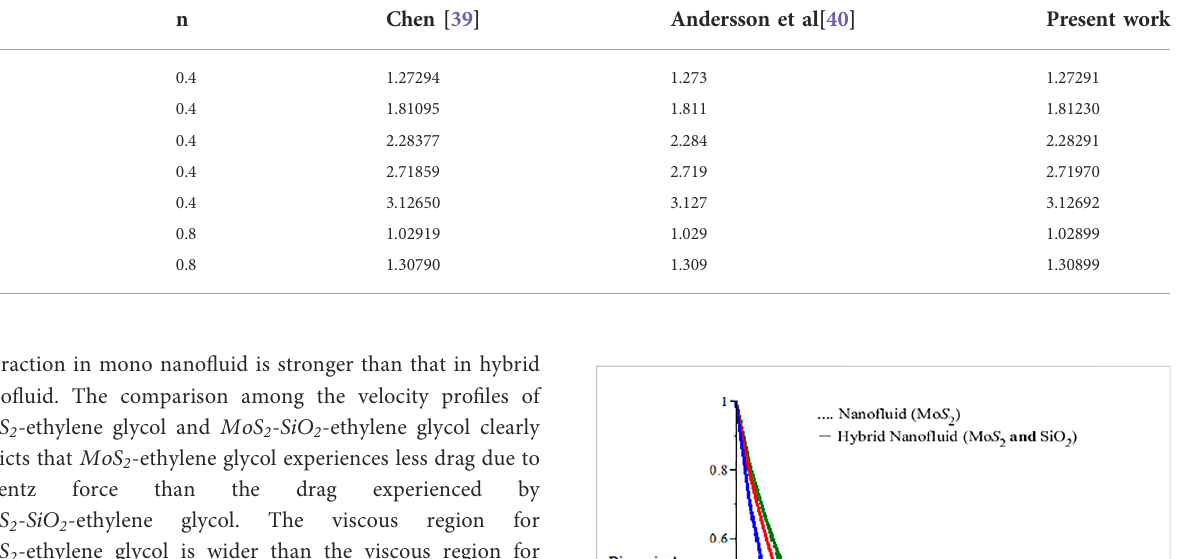
TABLE 3 Validation of the present work compared with published works in terms of − f 99 ( 0 ) considering λ M , λ N , ϕ 2 , ϕ 1 (cid:2) 0 .